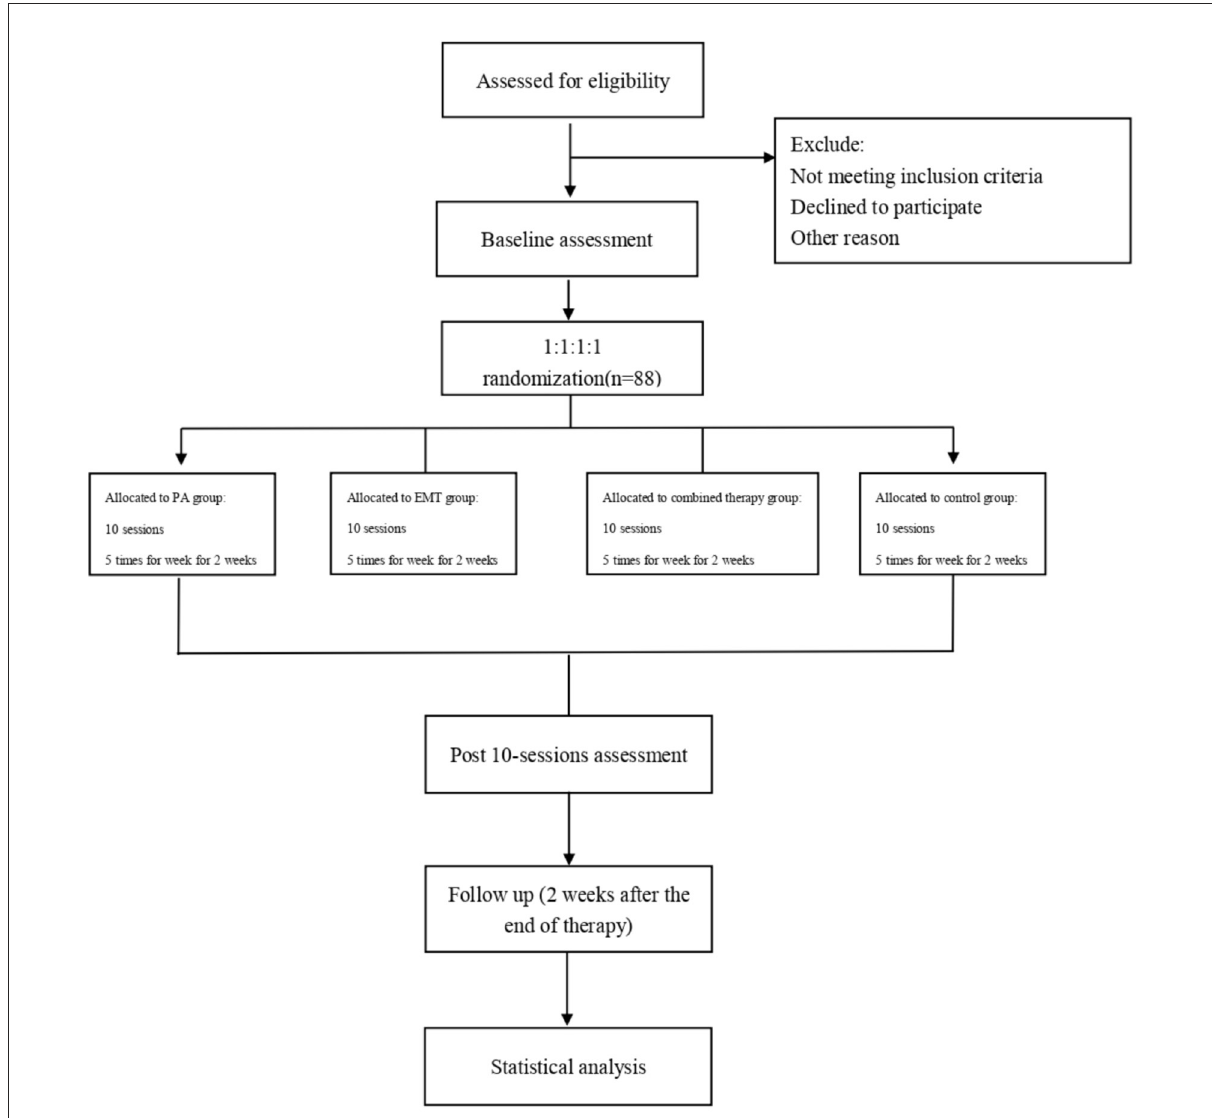
FIGURE1 Flowchart of the study design. PA, prism adaptation. EMT, eye movement